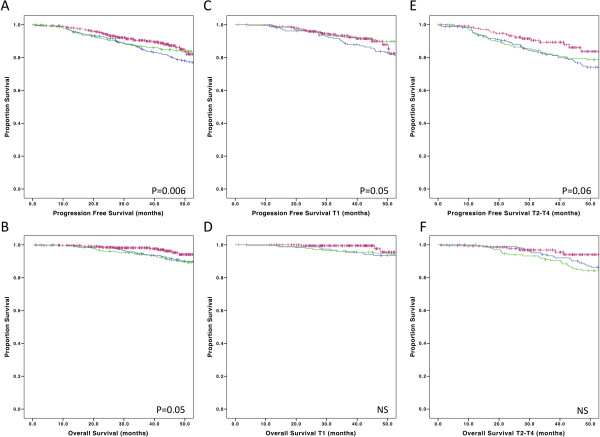
Progression free and overall survival respectively of the entire population: (A) and (B); patients with T1 tumors only: (C) and (D); and patients with T2-T4 tumors only: (E) and (F). Blue lines: patients treated in 1999-2002, green line: patients treated in 2003-2005, purple line: patients treated in 2006-2008.